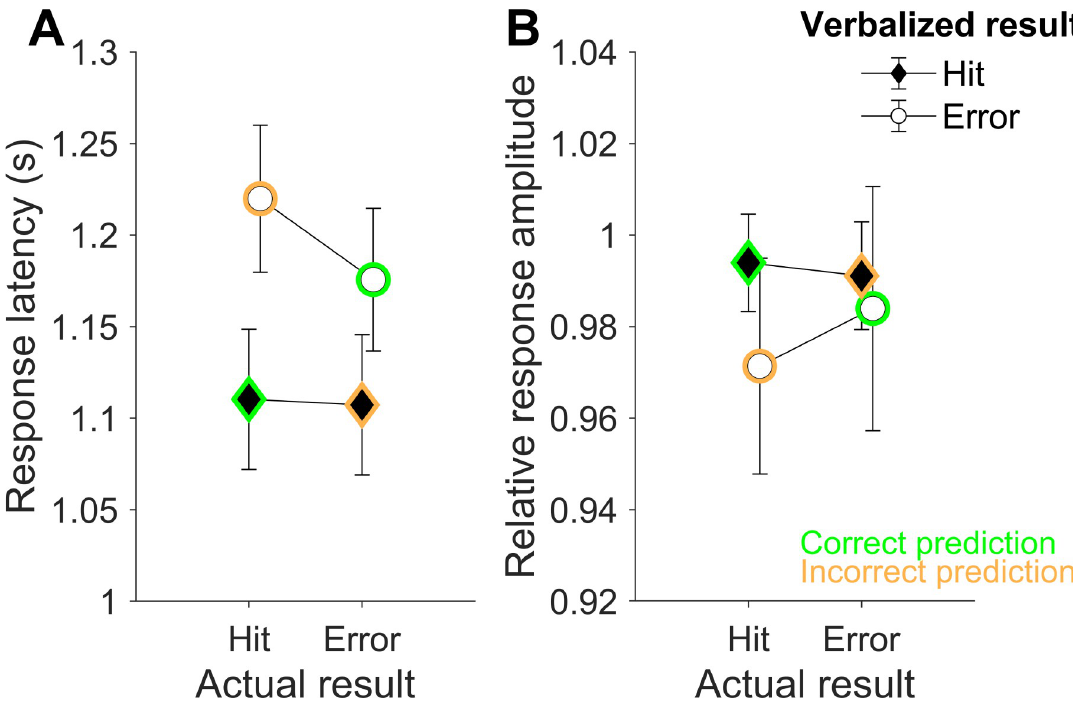
Fig 4. Speech characteristics of verbalized predictions. Average response latencies (A) and response amplitudes (B) differentiated after actual results of trials (actual hits or misses) and the verbalized responses (verbalized hits or misses). Error bars represent standard errors of the mean. Correction predictions are marked in green, incorrect predictions are marked in